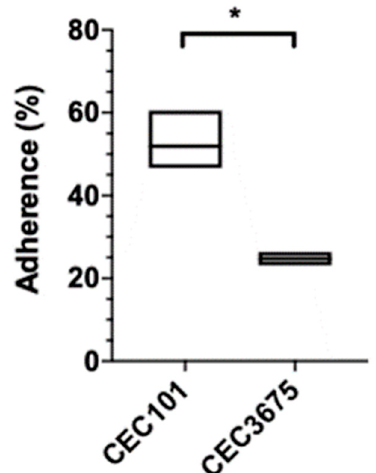
Figure 1. C. albicans isolates 101 and CEC3675 adhere differently to oral keratinocytes. Percentage of adherence of both isolates. Statistical analysis ( n = 3) was done using standard t-test. The asterisk represents p < 0.05.